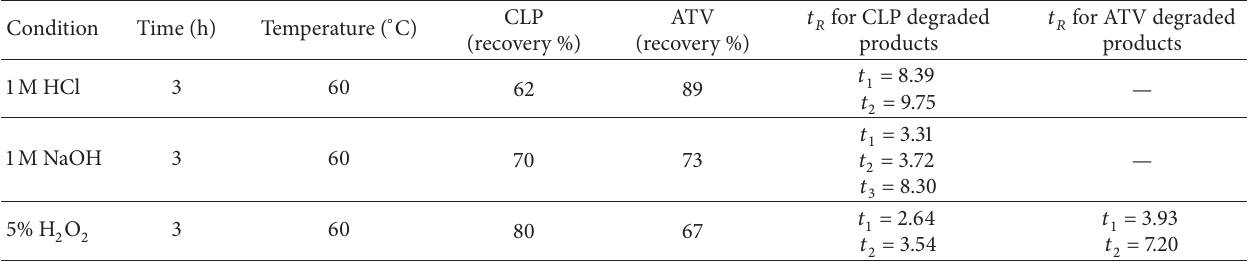
Table 6: Results of degradation studies on clopidogrel bisulfate and atorvastatin calcium.